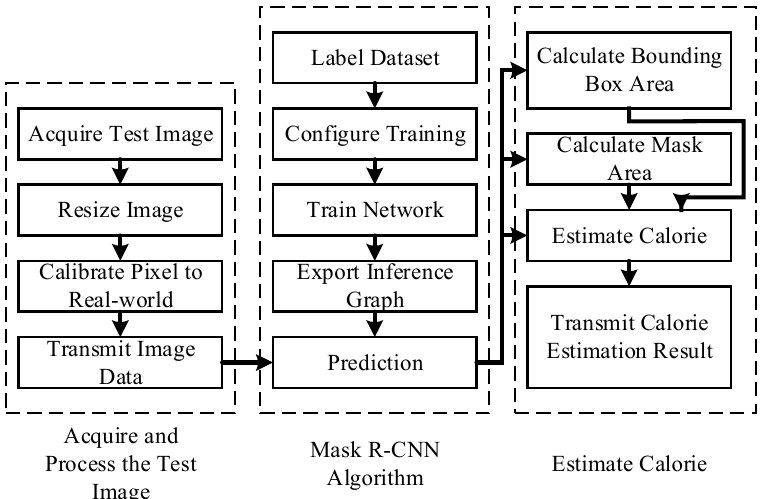
Figure 1. Flowchart of Gimbap Instance Segmentation and Calorie Estimation System. In step (1), the image is resized to 640 × 480 × 3, in order to increase transmission speed. In the calibration pixel to real-world block, the contour of the coin is detected. The contour’s minimum and maximum pixels on the x -axis ( min x , max x ) and on the y -axis ( min y , max y ) are calculated, separately. Based on the diameter of the coin, the physical sizes of each pixel on the x and y axes of the image are calculated as (1) and (2), where L ppx and L ppy are the physical sizes corresponding to each pixel on the x and y axes. D c is the diameter of the